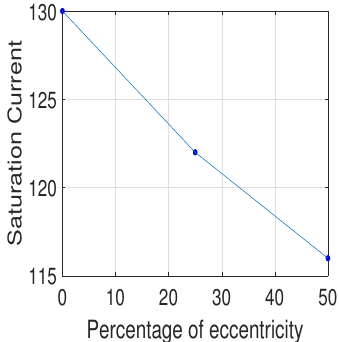
Figure 16. Experimental result for ( I d ) sat with severity of